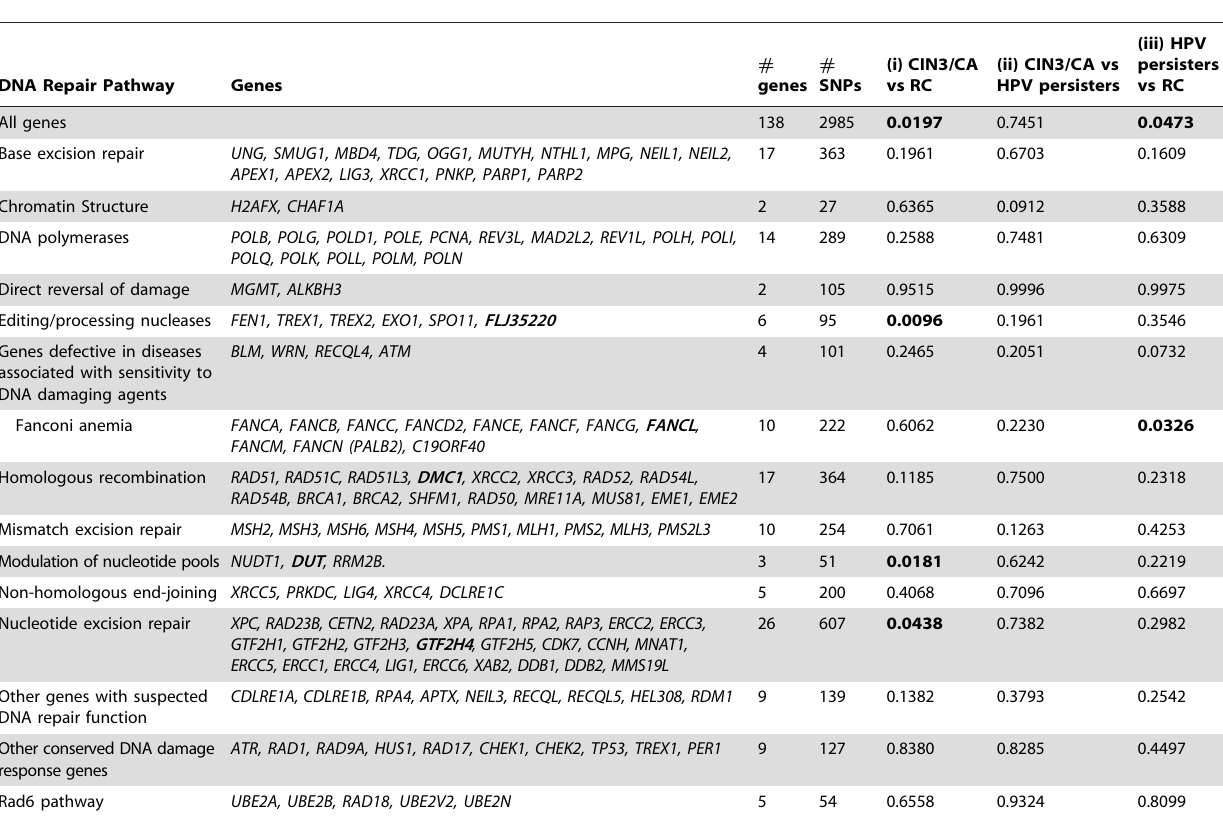
Table 1. Pathway-based tests for significance among DNA repair genes for associations with (i) cervical precancer/cancer, (ii) progression to cervical precancer/cancer, and (iii) HPV